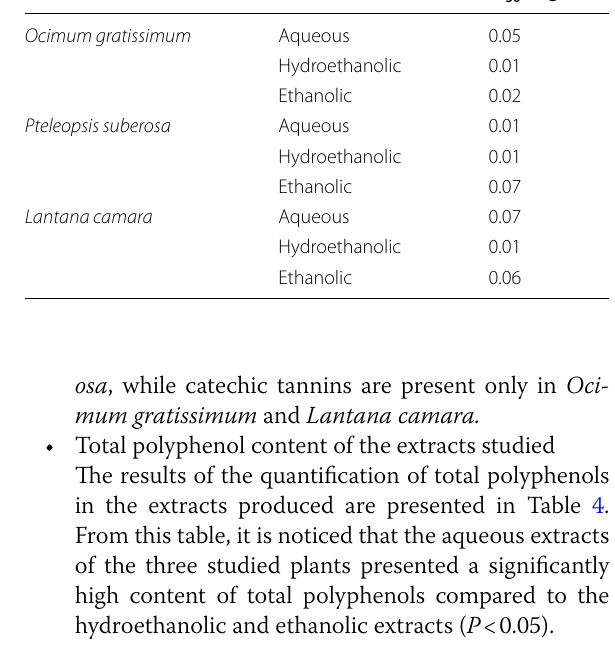
*Significantly different when the comparison between the extracts of each plant Table 5 Antioxidant power of the extracts expressed in IC Plants